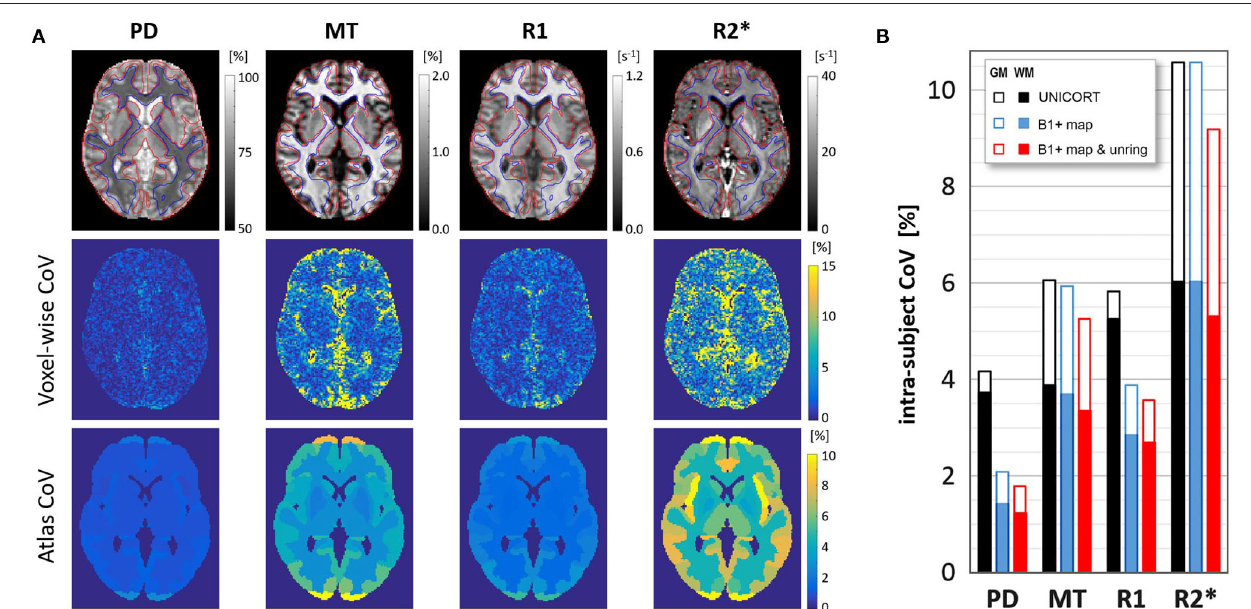
FIGURE 3 | (A) An axial slice for a typical volunteer showing PD, MT, R1, R2* parameter maps for the optimized 1.6-mm protocol (upper row) including contour lines of white matter (blue) and gray matter (red) masks used in the analysis; intra-subject CoV across the three scans (middle row); and the average CoV of MT, PD, R1, R2* in the atlas regions - see also Table 2 and https://clinicalmpm.github.io. (B) The effect of B1 Gibb’s ringing correction on the group-averaged scan-rescan variability in the gray and white matter for all 4 MPM contrasts. Note the negligible effect of using the 2-minute long B1 bias-field scan for the MT and R2* map.